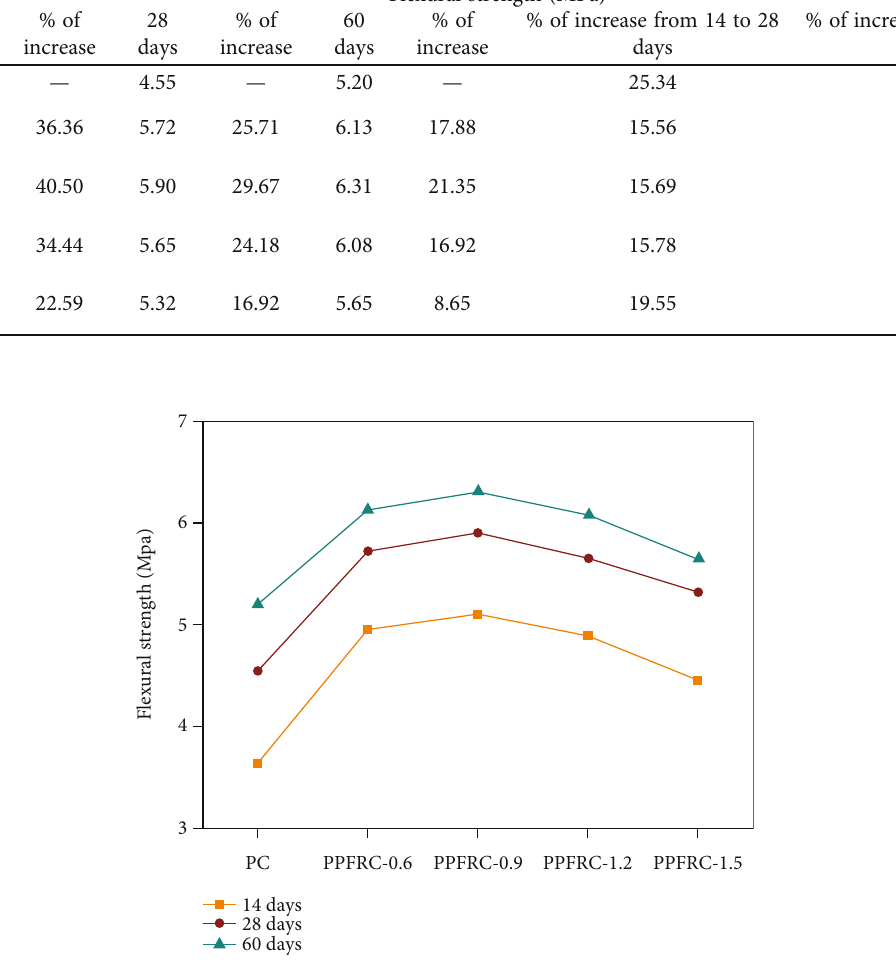
Figure 26: Flexural strength curves at 14, 28, and 60 days of